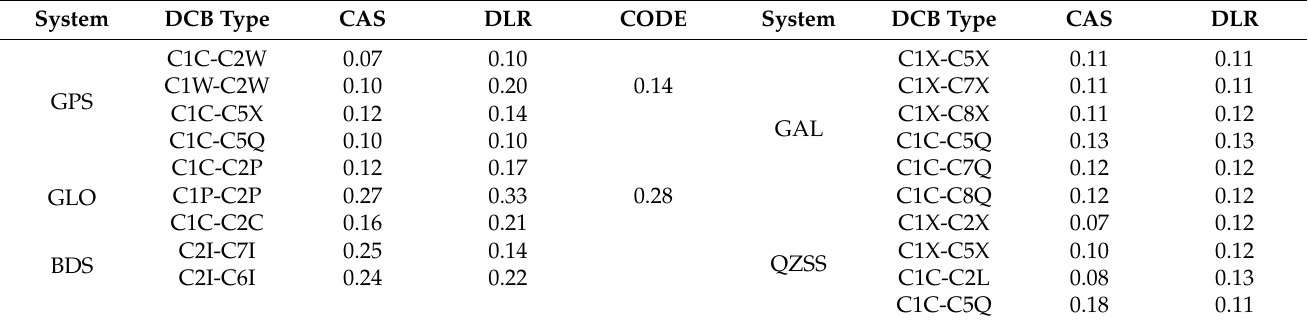
Figure 11. Mean difference and STD of QZSS DCB between IGDE and MGEX products.